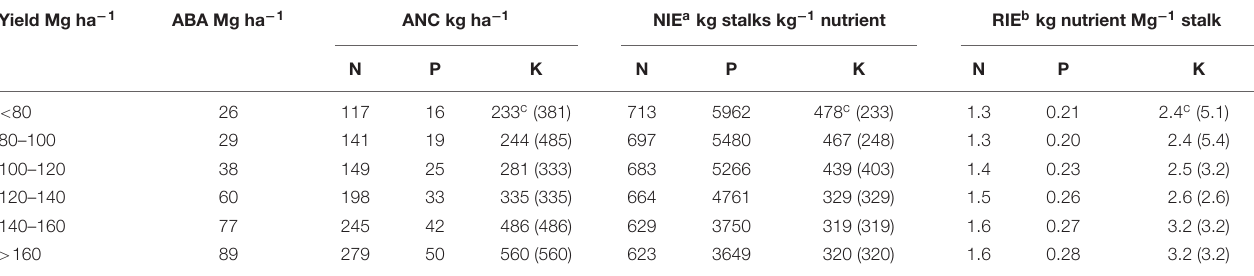
TABLE 3 | Sugarcane yield, aboveground biomass accumulation (ABA), aboveground nutrient content (ANC), nutrient internal efficiencies (NIE), and reciprocal internal efficiencies (RIE) of N, P, and K for diverse sugarcane yield ranges across three sites located in the Southeast region of Brazil. Yield Mg ha −